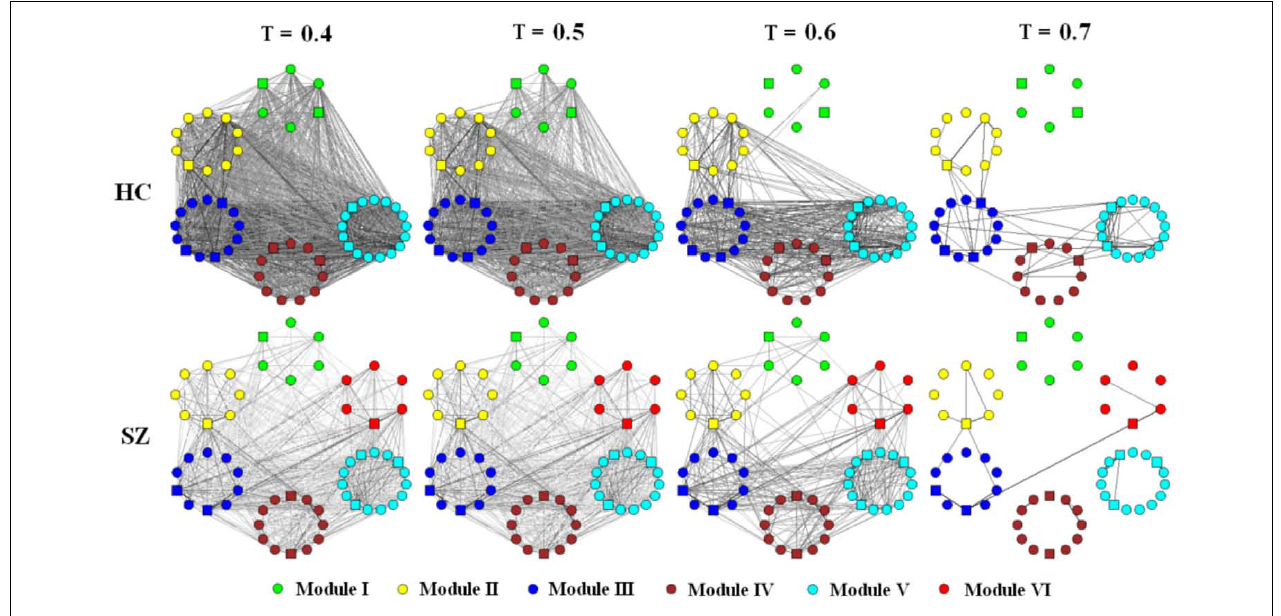
0.5, 0.6, and 0.7 are shown respectively. An edge (either inter- or intra-module edge) is shown in the graph if its weight bigger thenT.The thicker and the darker an edge, the higher its weight. Hubs are indicated by square nodes.